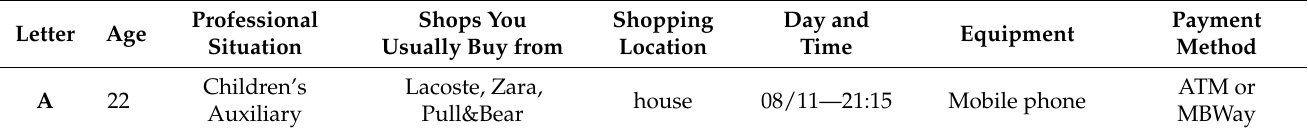
Table 2. Characterisation of the